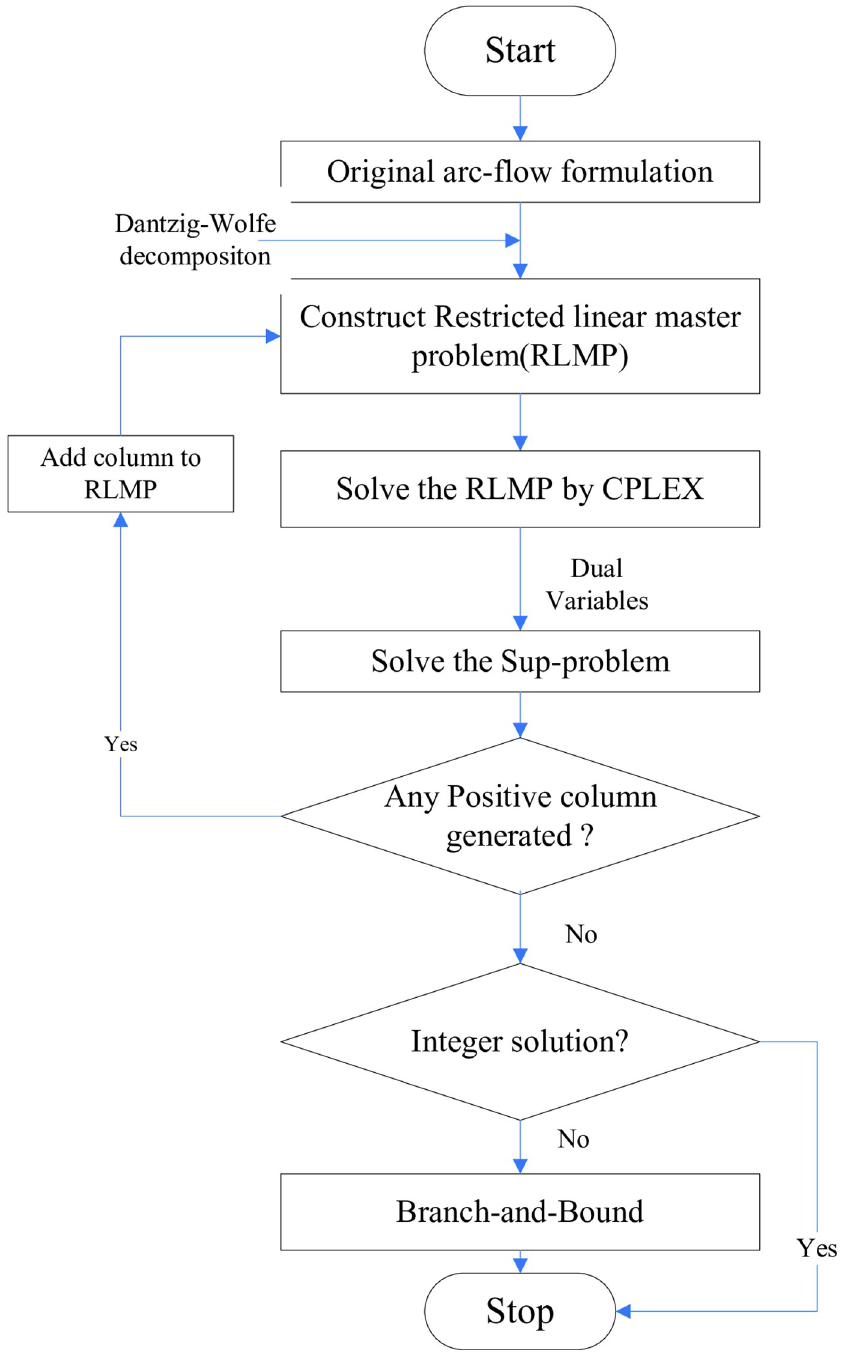
Fig 1. Flow chart of branch-and-price